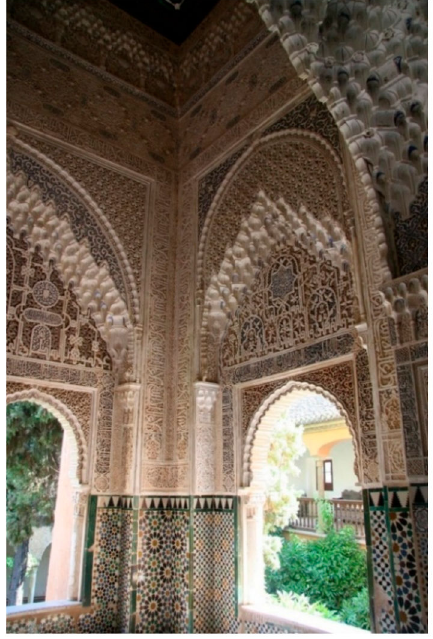
Figure 2. Arab sources from the Nasrid period already highlighted the quality of work of the master craftsmen in the alicatados and plasterwork. Plasterwork and alicatados in the Lindaraja balcony, Palace of the Lions. © Mar í a Elena D í ez Jorge,